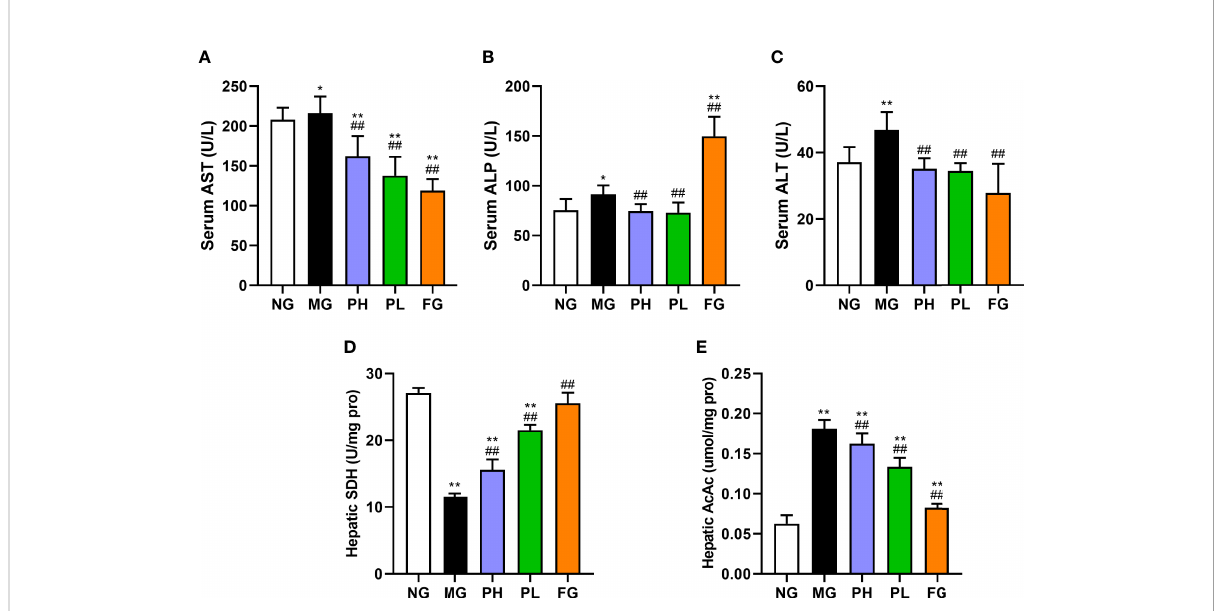
FIGURE 3 Effect of puerarin on hepatic function. (A) Serum AST; (B) serum ALP; (C) serum ALT; (D) hepatic SDH; (E) hepatic AcAc. Data were expressed as mean ± SD (n = 10). *p < 0.05, **p < 0.01, vs . NG; ## p < 0.01, vs .